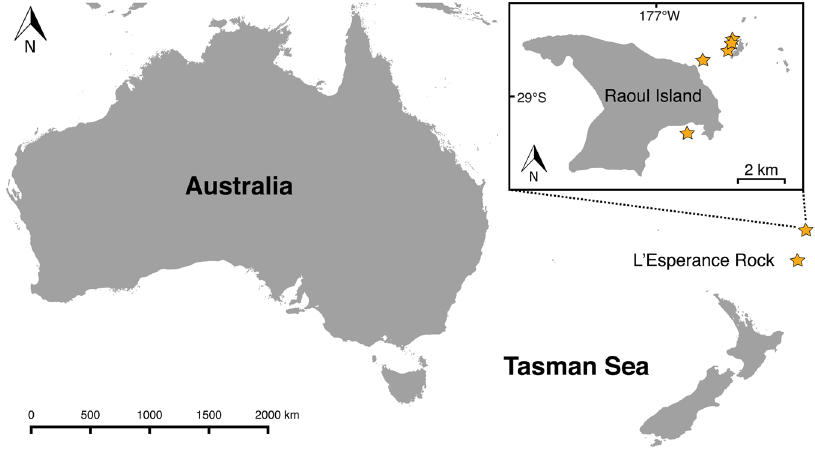
Figure 1. Map of the southeastern Indian Ocean and southwestern Pacific showing the location of the Kermadec Islands. Inset shows map of Raoul Island. Stars indicate sample collection localities of Tripneustes kermadecensis n. sp. The map is based on the Wikimedia Commons public domain map file BlankMap- World6 . svg (https://commons.wikimedia.org/wiki/File:BlankMap-World6.svg) and edited using the cross- platform geographic information system QGIS v. 2.8.2 (Quantum GIS Development Team (2016). Quantum GIS Geographic Information System. Open Source Geospatial Foundation Project.